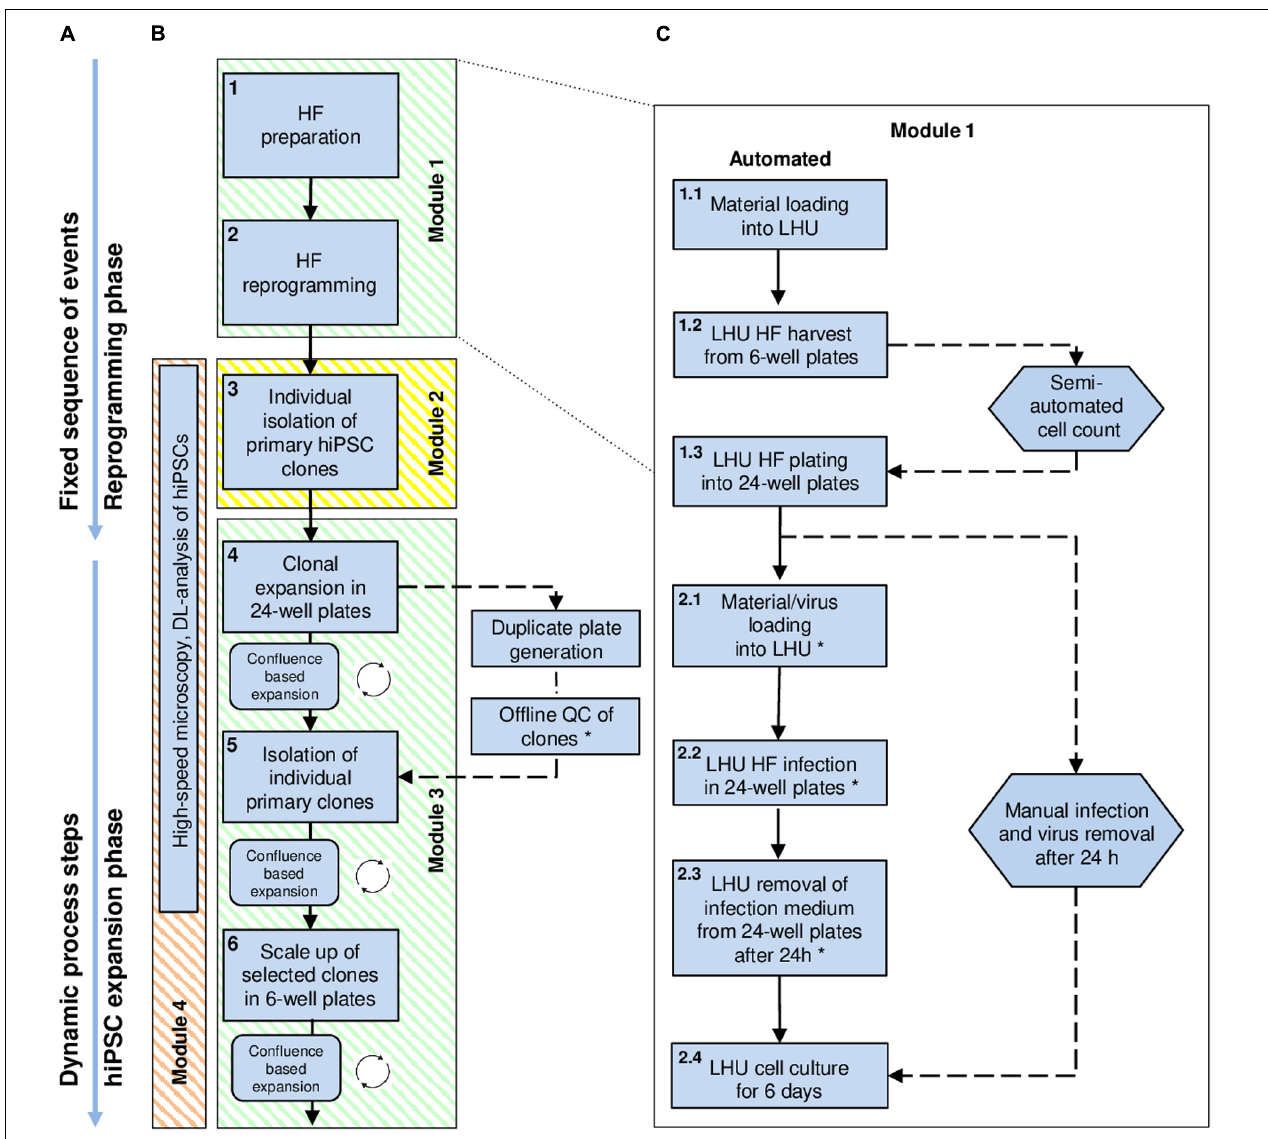
FIGURE 1 | High-level workflow chart for automated reprogramming of human skin fibroblasts (HF) into hiPSCs using the StemCellFactory. (A) The process of hiPSC generation can be divided into two phases: (i) the initial reprogramming phase following a fixed sequence and (ii) the dynamic phase of hiPSC expansion. (B) Blue square boxes represent individual protocol steps embedded in the automation process. They are numbered, arranged in consecutive order, and grouped into distinct modules. Modules 1 and 3 (green) are running on the LHU. Module 2 (yellow) is performed using the CellCelector, and Module 4 (orange) by the upgraded high-speed microscope (Nikon). (C) Detailed protocol steps developed for the reprogramming of HF (Module 1, protocol steps 1 and 2). Straight arrows: consecutively executed steps; circular arrows: repetitive steps; dashed arrows: steps performed manually outside the StemCellFactory; Hexagon shapes indicate steps involving manual handling. Steps marked with an asterisk are automated but can also be performed manually, depending on the biosafety classification of the laboratory environment. DL, Deep-learning; HF, Human fibroblasts; LHU, Liquid handling